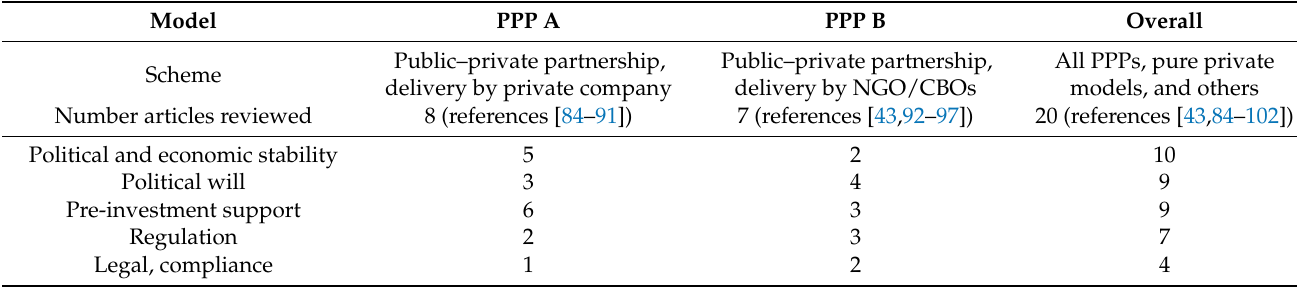
Table 5. Ranking of the relevance of political economy criteria. Note: “Capacity building” includes local capabilities, and “Institutional set-up” includes network and context of institutions and other formalized